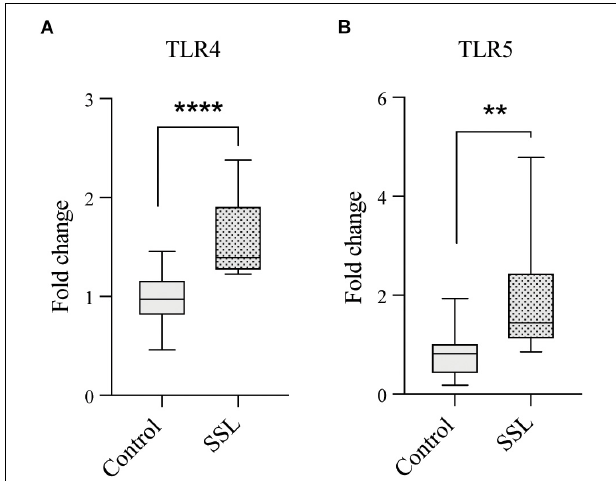
FIGURE 4 | SSL exposure increased levels of proinflammatory bacterial products. Culture of fecal bacteria in SSL-supplemented medium resulted in increased levels of (A) Gram-negative cell wall component lipopolysaccharide (LPS) and (B) Flagellin, a flagellum component, measured by colorimetric indicator SEAP in engineered HEK-Blue reporter cells expressing TLR4 and TLR5, respectively ( n = 15, three biological replicates). Statistical significance of pairwise comparisons was determined with a two-tailed Student’s t -test, using Graph Pad Prism * < 0.05, ** < 0.01, *** < 0.001, **** <